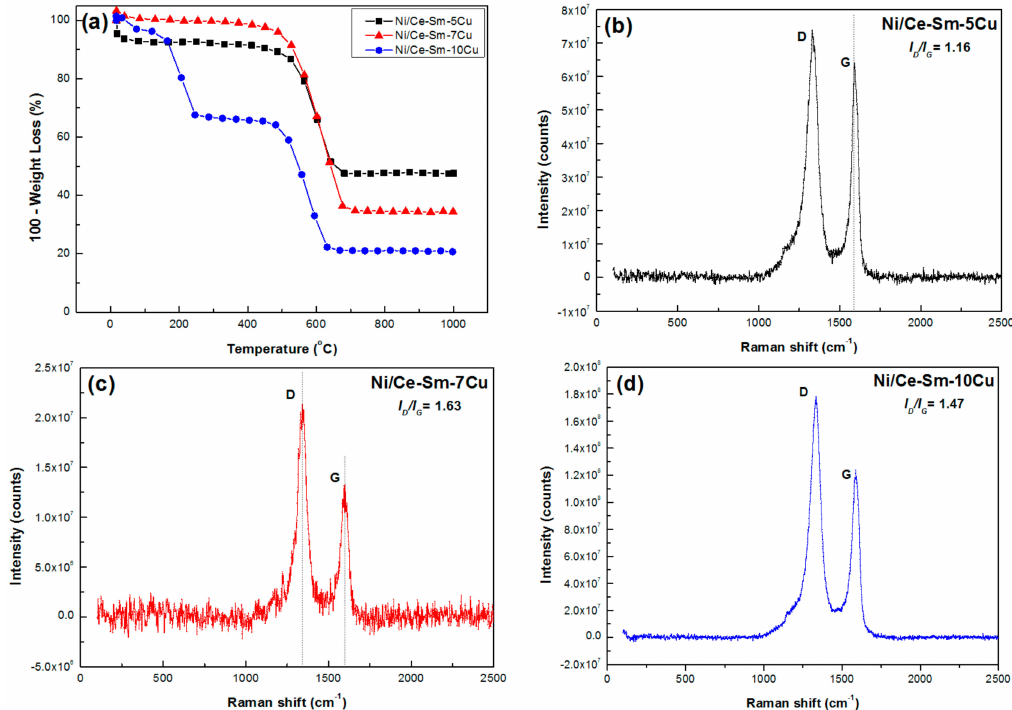
Figure 15. ( a ) TGA profiles of the Ni/Ce-Sm-xCu (x = 5, 7, and 10 at.%) catalysts; Raman spectra of the used: ( b ) Ni/Ce-Sm-5Cu ( c ) Ni/Ce-Sm-7Cu, and ( d ) Ni/Ce-Sm-10Cu